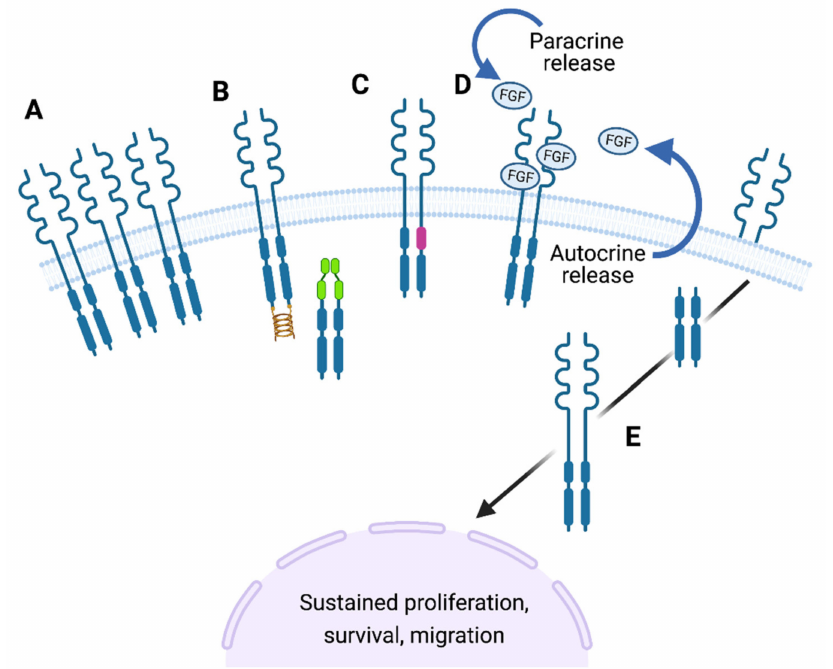
Figure 3. FGF signalling pathway alterations in cancer. The FGF signalling pathway can be- come altered in a number of methods in cancer to cause sustained cell proliferation and survival: ( A ) Overexpression of FGF receptors cause ligand independent activation, e.g., FGFR2 in gastric cancer. ( B ) Receptor translocations can occur also leading to ligand independent activation of sig- nalling, e.g., FGFR N-terminal fusion with transcription factors (green) or C-terminal fusion with TACC (Transforming Acidic Coiled Coil) proteins (gold). ( C ) Activating mutations (pink) within the FGF receptors cause constitutive activation even in absence of the ligand, e.g., FGFR2 in endometrial cancer. ( D ) Paracrine or autocrine overexpression of FGF ligands can lead to increased FGF signalling, e.g., FGF1 in ovarian cancer. ( E ) Sub-cellular translocation of either the full length or a cleaved version of the receptor can occur, for example to the nucleus where it could act as a transcription factor, e.g., FGFR1 in pancreatic or breast cancer [28,29]. Created with BioRender.com. Other FGF ligands, including FGF5, FGF7 and FGF10, have been reported to be overexpressed in PDAC leading to increased cell proliferation and invasion [40–43]. In